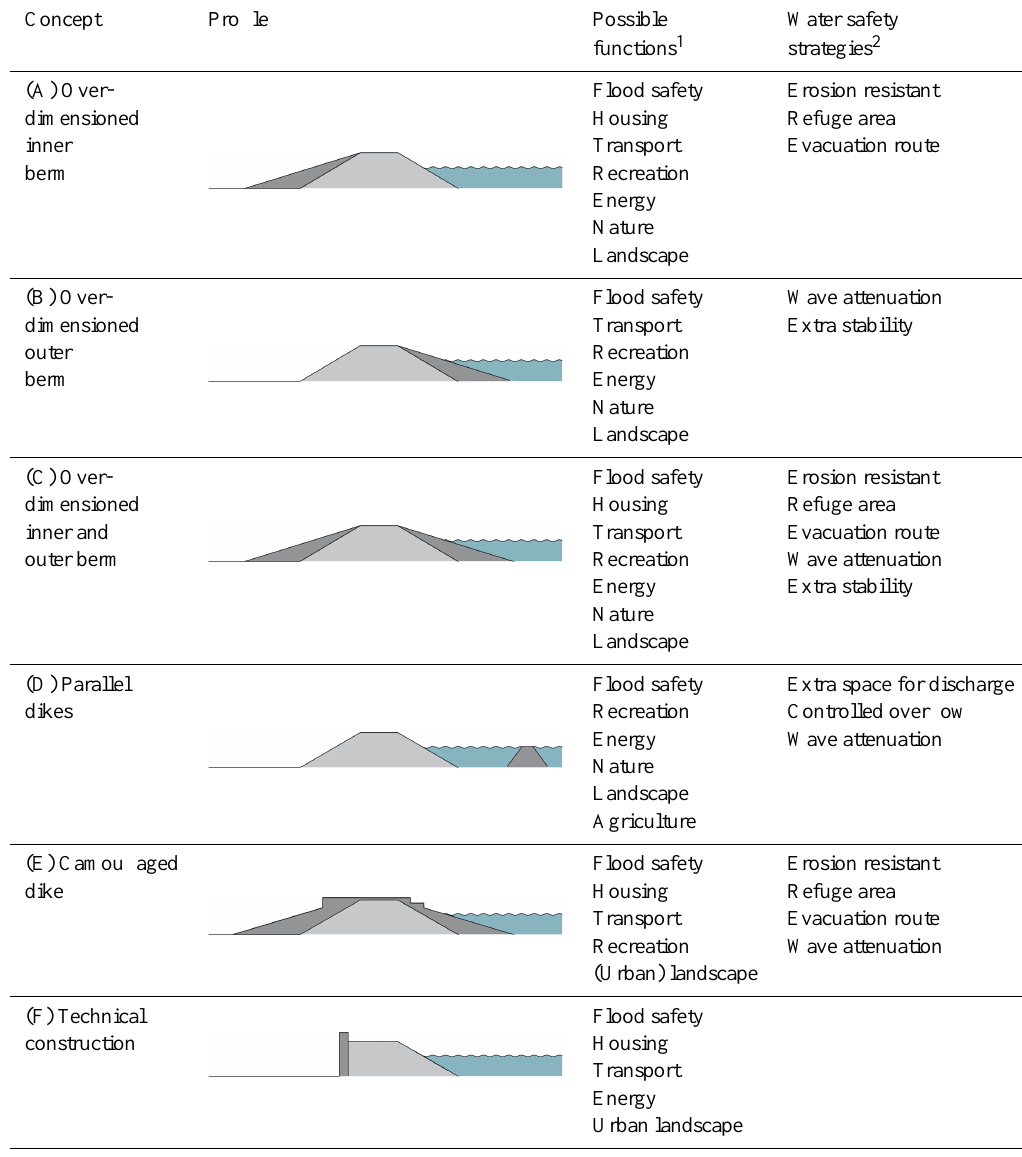
Table 2. Overview of robust multifunctional flood defenses (based on Klijn and Bos, 2010), with associated possible functions and water safety